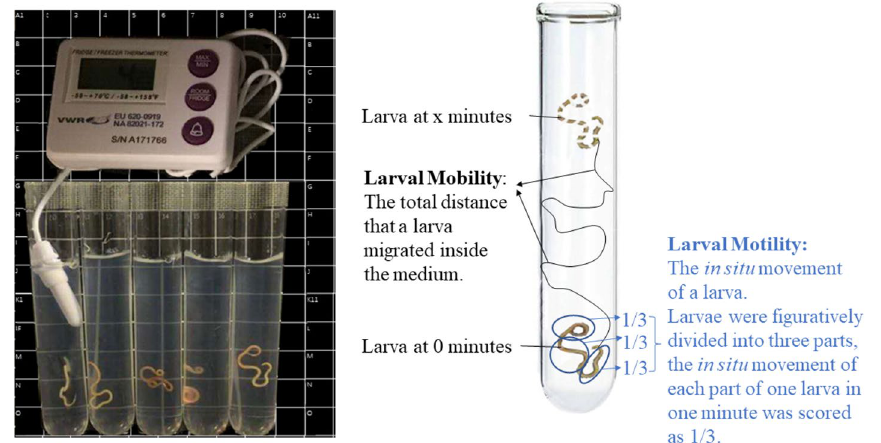
Figure 1. Experimental setup (left) and measurements of larval movements